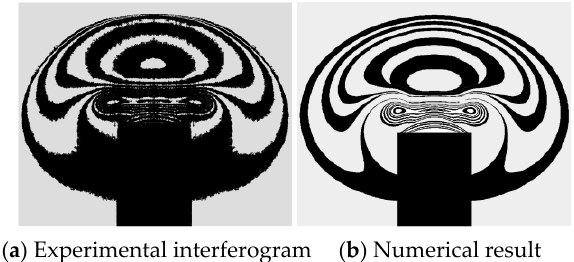
Figure 5. Comparison of numerical and experimental interferograms in the shock-tube experiment.